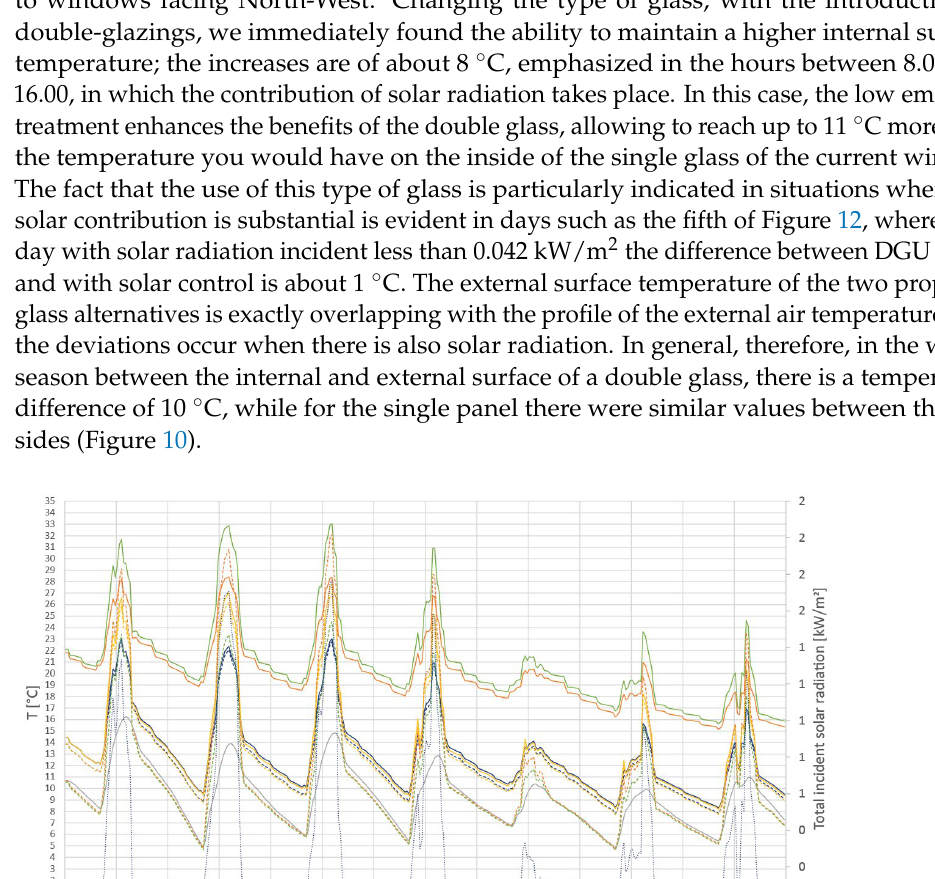
Figure 11. Internal surface temperature of current glazing system for different orientations; summer period: July, first week (floor 2).